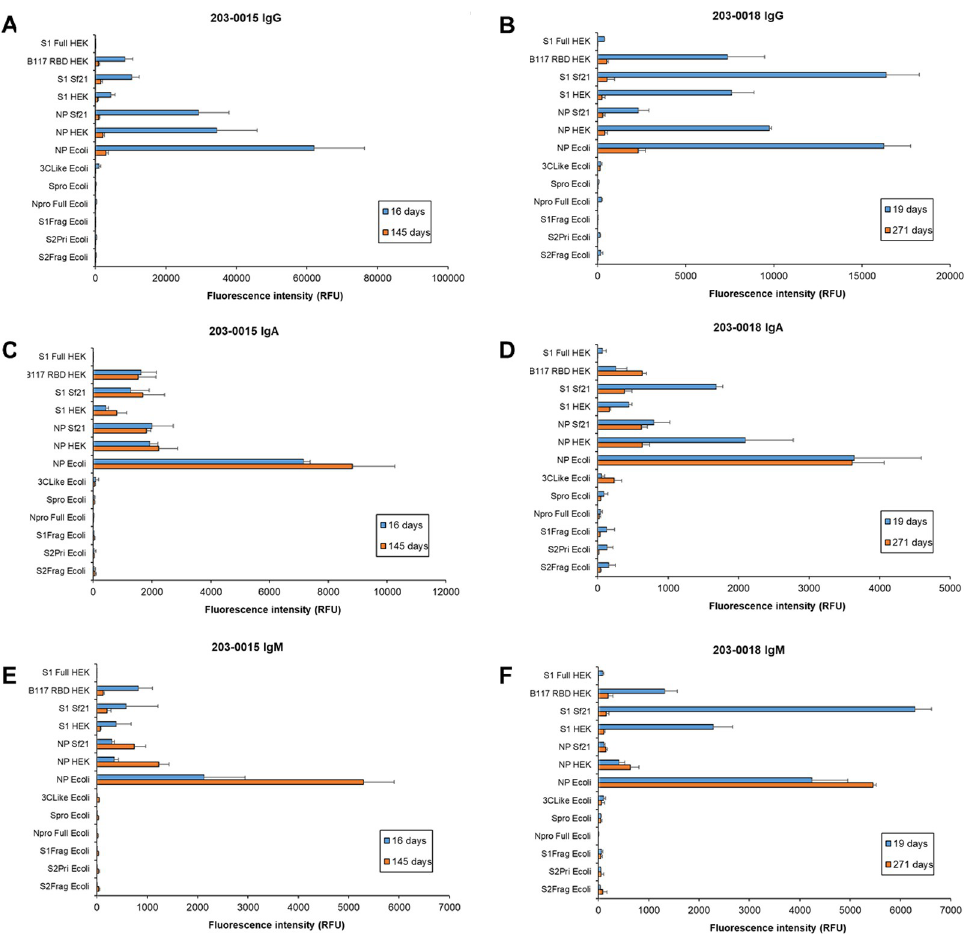
Fig 8. Dynamic binding of patient serum antibody isotypes over longer term for severe COVID-19 disease. Bar charts represent binding intensity data for serum (A,B) IgG, (C,D) IgA, and (E,F) IgM binding to SARS-CoV-2 antigens for patient 203–0015 ( A,C,D ; M, 69 years) and 203–0018 ( B,D,F ; M, 66 years) at 16 and 145 days, and 19 and 271 days post- first symptom onset, respectively. Bars represent the average binding intensity from three replicate experiments with error bars of +/- 1